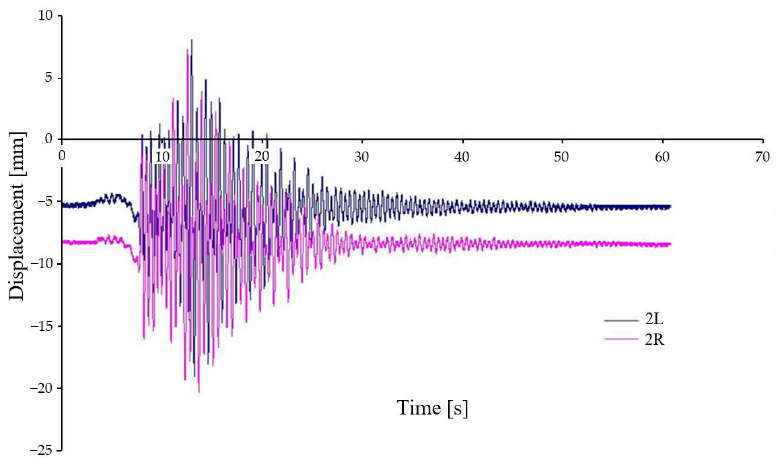
Figure 17. Relative displacement between car body and chassis frame—variant D-IV.